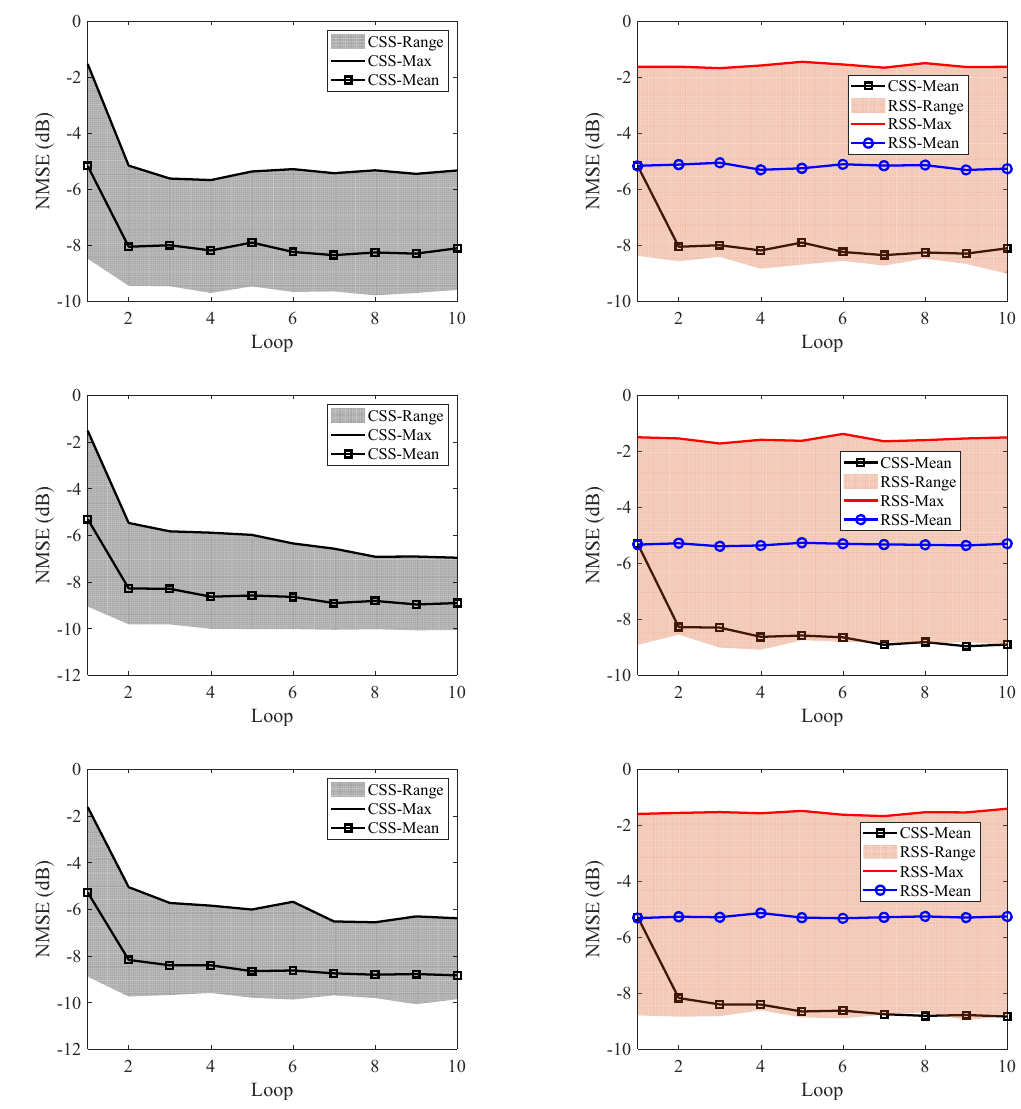
Figure 23. NMSEs of the proposed cognitive sparse imaging method and the RSS method against the processing loops under three different WBIs.